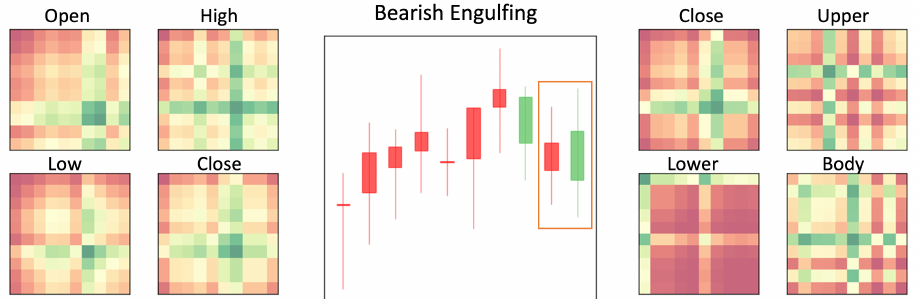
Figure 14. Example of Bearish Engulfing pattern and GASFs. The middlemost figure is the original candlesticks. The red and green candlesticks represent closing prices are higher than the opening prices are not. The left and right sides are the heatmaps of GASFs. The range of the heatmap is ( − 1,1 ) , where red equals − 1 and green equals 1.